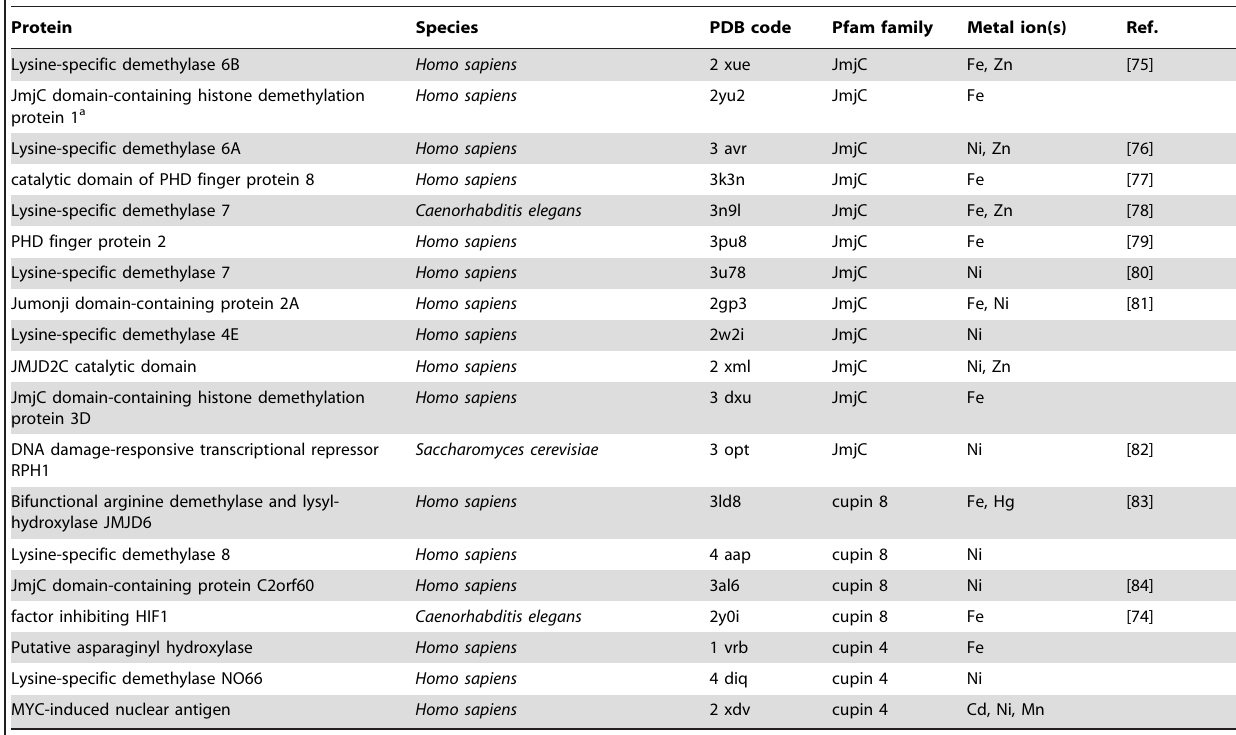
Table 1. JmjC protein